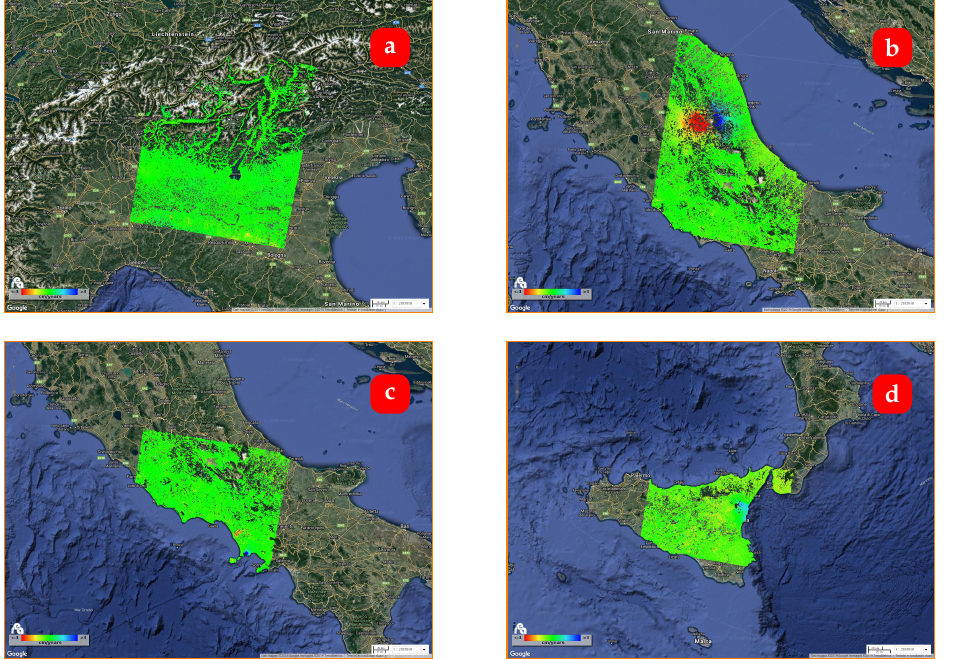
Figure 13. Mean deformation velocity maps relevant to a selection of four frames of the overall DInSAR dataset shown in Figure 12 including the: ( a ) Lombardia, Emilia-Romagna, Veneto and Trentino Alto Adige Regions, ( b ) Marche, Umbria, Lazio, Abruzzo, Molise and Campania Regions, ( c ) Lazio, Campania, Abruzzo and Molise Regions, and ( d ) Sicily and Calabria